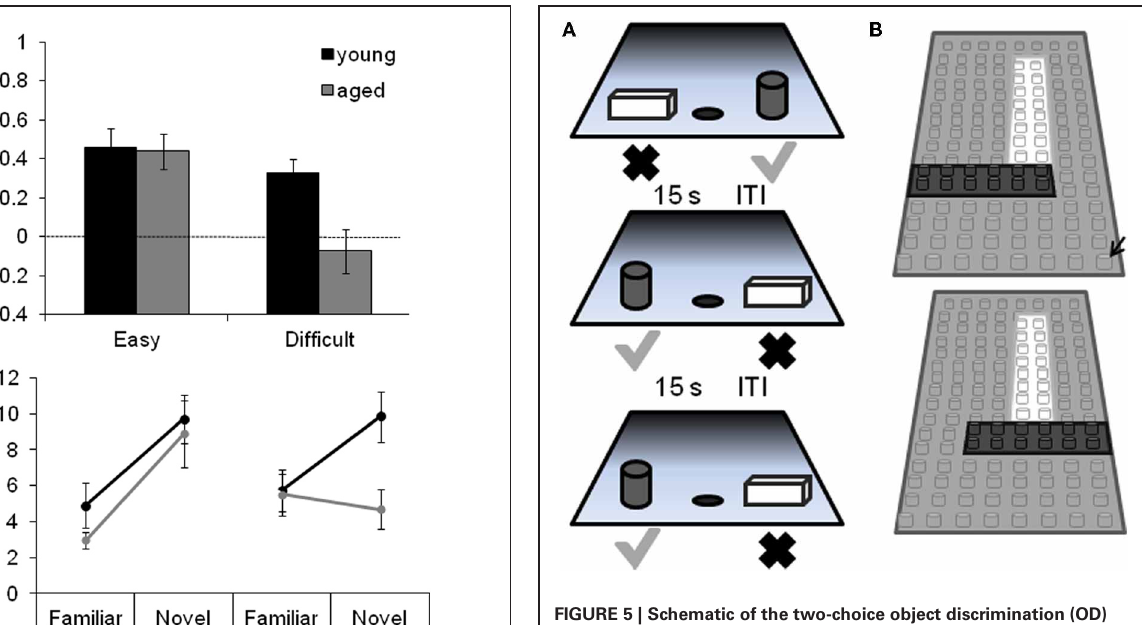
FIGURE 5 | Schematic of the two-choice object discrimination (OD) apparatus and procedure. (A) Examples of three different OD task trials. For each OD problem, an object is placed over the left and right food well. The gray cylinder represents the rewarded object (gray check) and the other object of the pair (rectangular cube; black X) was never rewarded. A 15s inter-trial interval (ITI) is imposed between successive trials, and the side of the rewarded object pseudo-randomly changed across trials. (B) A schematic of the pair of LEGO ® objects with 86% feature overlap. Feature overlap is calculated by dividing the number of LEGO ® “pips” (indicated by the black arrow) that were the same between the two objects by the total number of bits in a single object (reprinted with permission Burke et al.,